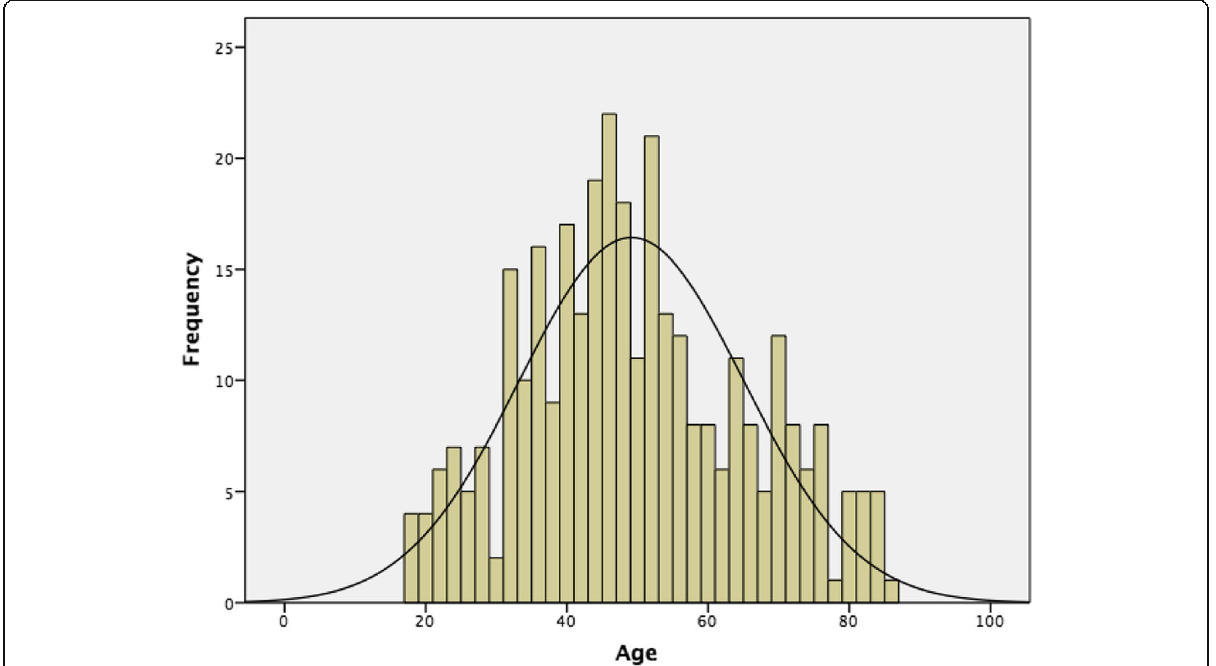
Fig. 1 Age distribution of males over 18 years with hydrocoeles in Samoa